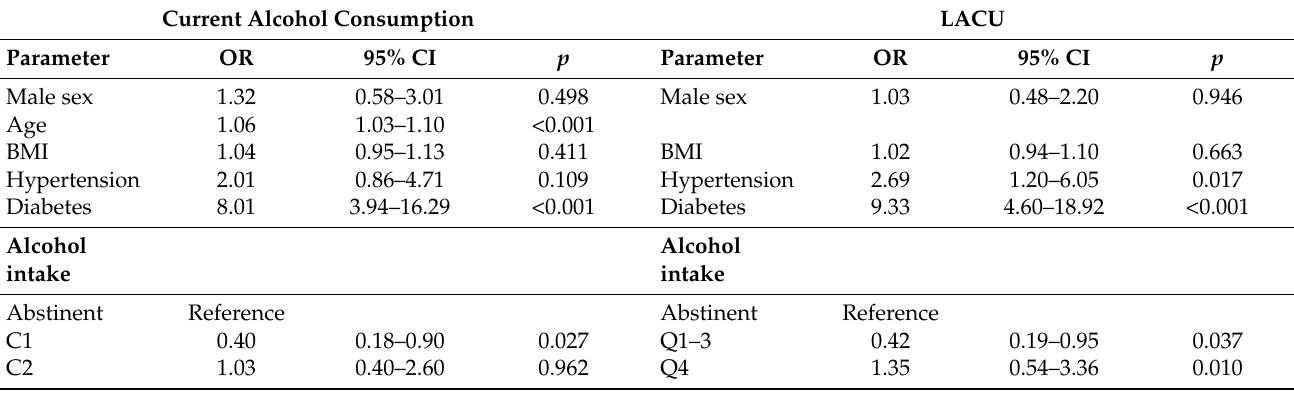
Table 6. Multivariate analysis of parameters associated with